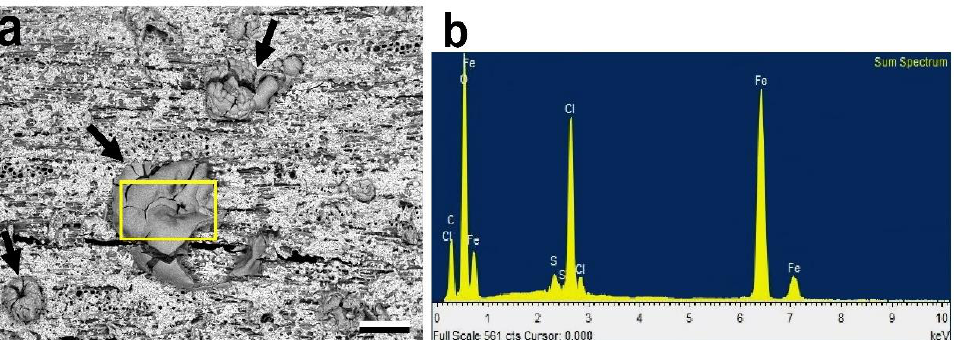
Figure 3. ( a ) SEM micrograph of a mock-up after the 1st application of the gelled DFO-B buffered at pH 8.6 showing formations (arrowed) that remained on the surface after cleaning, scale bar = 100 µ m; ( b ) EDS elemental analysis of a formation.